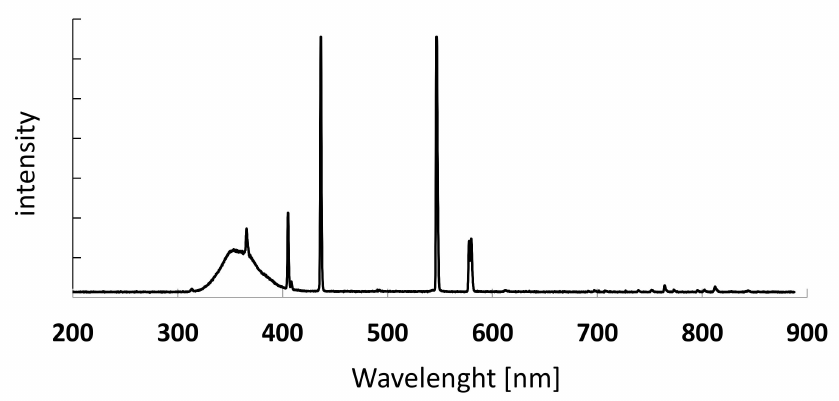
Figure 6. Emission spectra of six UV lamps (6 × 15W, Cleo, Berlin, Germany) with the cumulative radiation intensity of 83.4 W / m 2 UV and 100 W / m 2